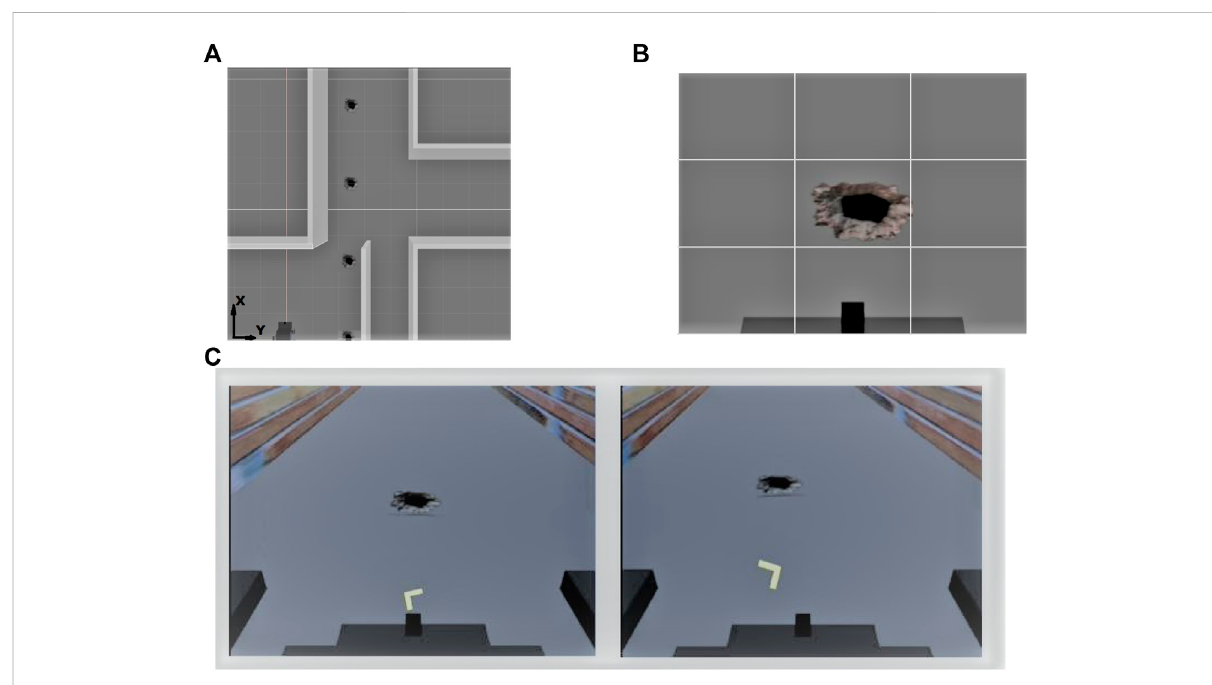
FIGURE 2 Virtual simulation environment. (A) Top-view: the holes are placed along the corridor, separated by 3 m each. (B) First-person view: the hole appears in the center of the view when the user gets close to it. (C) Two possible visualizations of the directional cues to advise left or right turning task, as visualized in the video streaming in the fi rst-person view as detailed in Section 2.4.